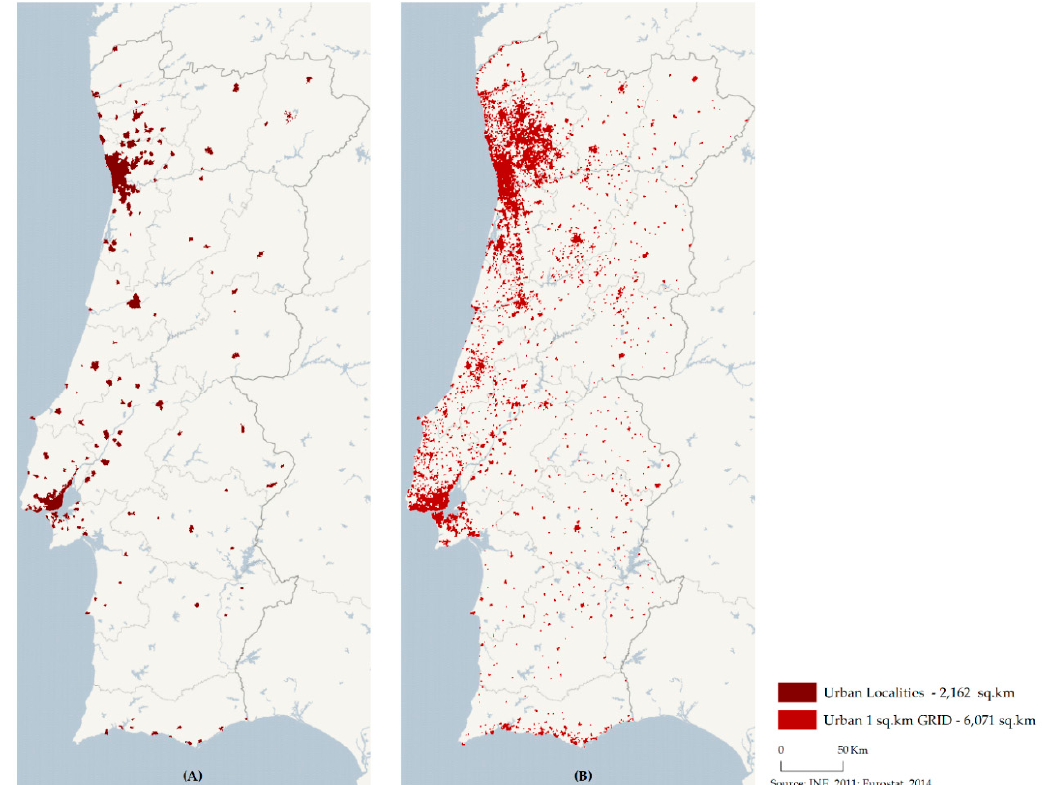
Figure 6. Urban areas according to Statistics Portugal 2011 urban localities and the GEOSTAT 2011 1 sq.km grid ( A ) Localities ( >= 5000 inhabitants); ( B ) 1 sq.km grid (Population density > 300 inhabitants per sq.km).